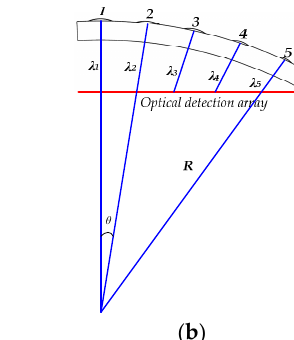
Figure 2. ( a ) Area division of the variable focus surface compound eye, where the three different colors represent the three regions divided; ( b ) the positional relationship between sub-eyes and the focal planes at all levels: R -curved base radius; θ - suborbital deflection angle; λ 1–5 -distance between the sub-eyes and the optical detection array.